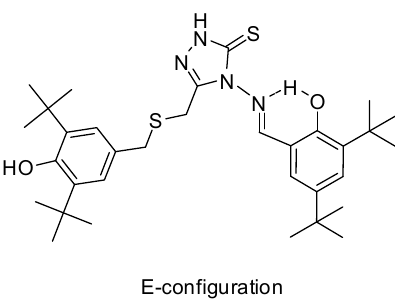
Figure 2. Proposed intra-molecular hydrogen bonding of 7 .